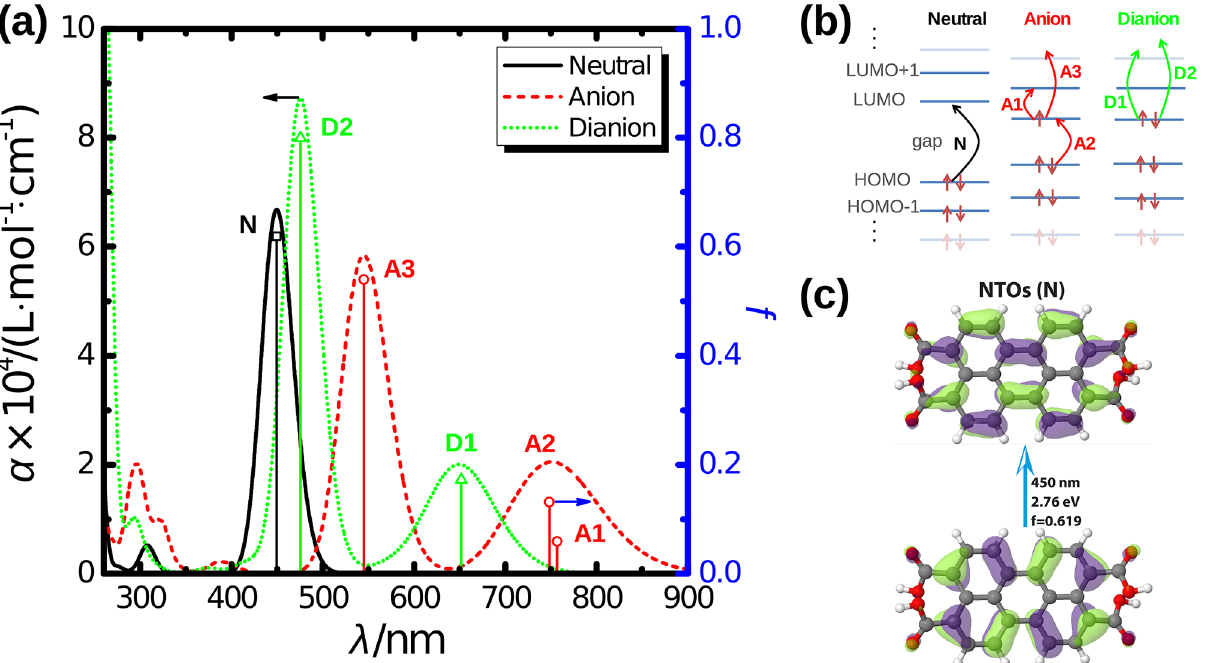
Figure 3. ( a ) Absorption spectra of the neutral (black) molecule as well as of the anionic (red) and dianionic (green) species. The absorption coefficient α (continuous graphs) and the oscillator strength f (open symbols with drop-lines) of the different species are depicted on the left and right ordinate, respectively. ( b ) Scheme illustrating the molecular orbitals that are involved in the electronic transitions responsible for absorption. ( c ) Natural transition orbitals (NTO) for the first excited state of the neutral molecule corresponding to an excitation from the highest occupied molecular orbital (HOMO) to the lowest unoccupied molecular orbital (LUMO). The excited state calculations employed CAM-B3LYP/aug-cc-pVDZ for MP2/6-311G(d,p) optimized